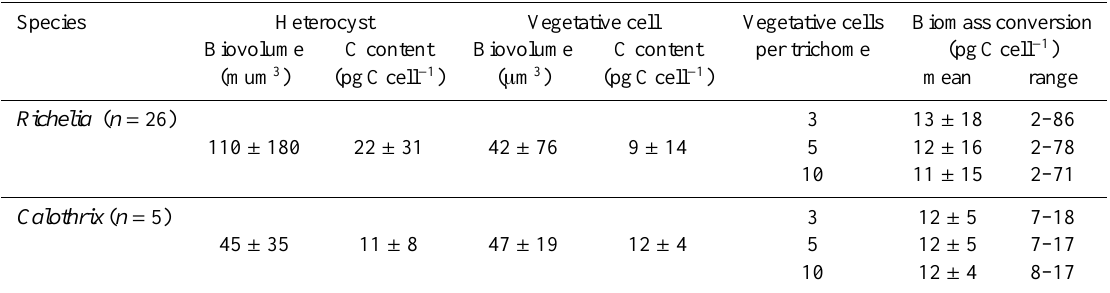
Table 4. Biomass conversion factors estimated for Richelia and Calothrix trichomes based on biovolume measurements by Foster et al. (2011) and assuming trichome composition of one heterocyst and three, five or ten vegetative cells. Carbon contents are calculated using the Verity et al. (1992) model. Numbers are mean ± standard deviation when applicable. Species Heterocyst Vegetative cell Vegetative cells Biomass conversion Biovolume C content Biovolume C content per trichome (pgCcell − 1 ) (mum 3 ) (pgCcell − 1 ) ( µ m 3 ) (pgCcell − 1 ) mean range Richelia ( n =